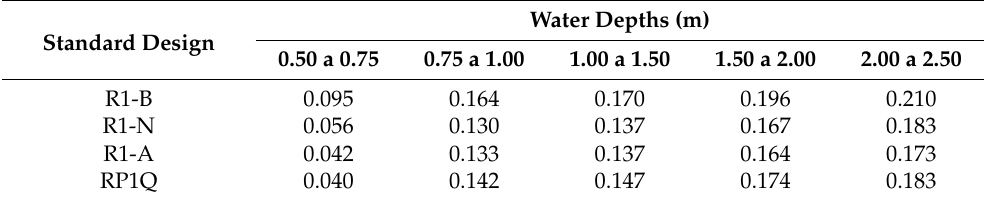
Table 2. Percentage of a damaged building (PED)